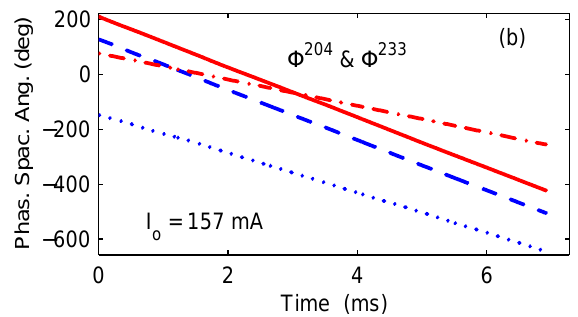
FIG. 6. (Color) Linear evolution of modal phase space angles F 204 and F 233 at the ALS (longitudinal instabilities, I 0 (cid:1) 157 mA). Dash-dotted line: F 204 , even fill; dotted line: F 233 , even fill; solid line: F 204 , square-wave fill; dashed line: F 233 , square-wave fill. Square-wave fill couples the two frequencies and creates a mixed eigenmode, so that U 204 and U 233 are phase locked.